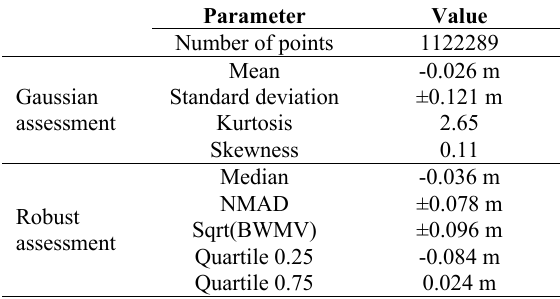
Table 2. Statistical results of the anastylosis process for the current remains.